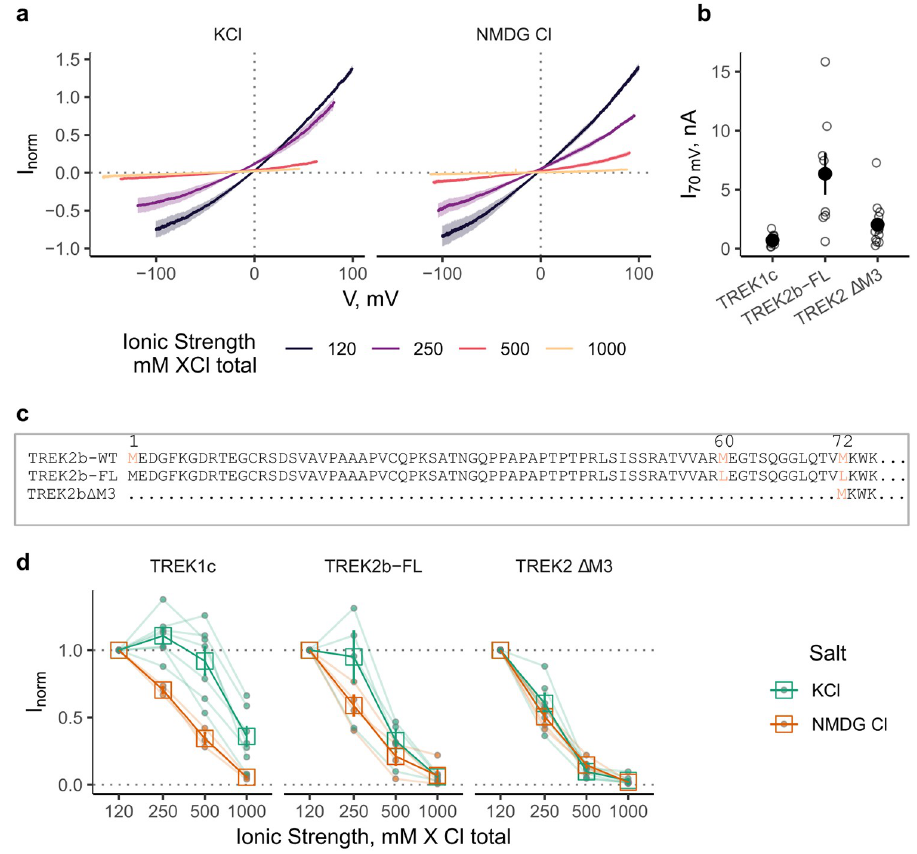
Fig 1. TREK Δ m3 IV-curves in high internal ionic strength. a ) Average normalized IV-curves in varying ionic strength. Shaded area represents SEM, n = 7 and 5 for KCL and NMDG respectively. Note that the IV curves are offset to each other on the x-axis, this is because the voltage-step protocols for each test-solution where modified in order to sample a ± 100 mV driving force range for K + . b ) Absolute current values at 70 mV for the baseline condition (120 mM KCl) for each patch. c ) Sequence alignment of the N-termini of ATI variants of TREK2 utilized in this study. d ): Normalized currents in varying ionic strength, corrected for driving force. There was considerable variability in the response between different constructs and between replicates. n > 3. Faint lines and filled circles represent responses of individual